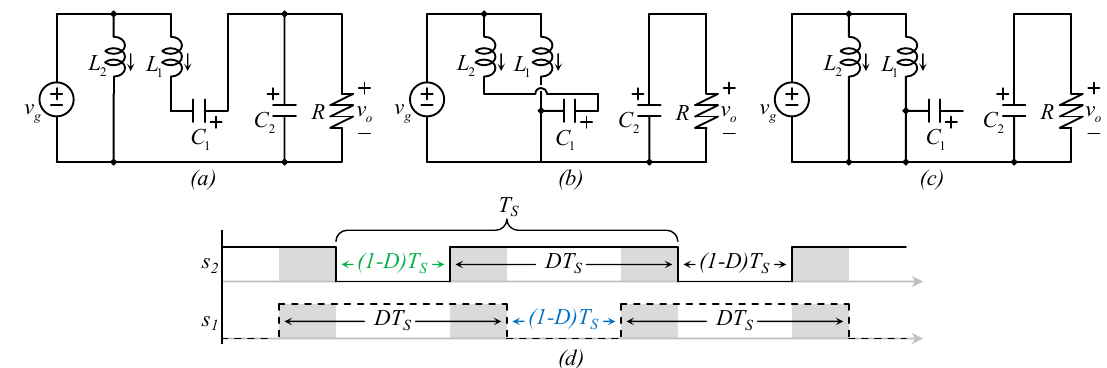
Figure 6. Equivalent circuit according to the switching state ( a ) s 1 = 1 and s 2 = 0, ( b ) s 1 = 0 and s 2 = 1, and ( c ) s 1 = 1 and s 2 = 1. In addition, ( d ) shows the time period of PWM signals (zoom intro signals in Figure 5c).